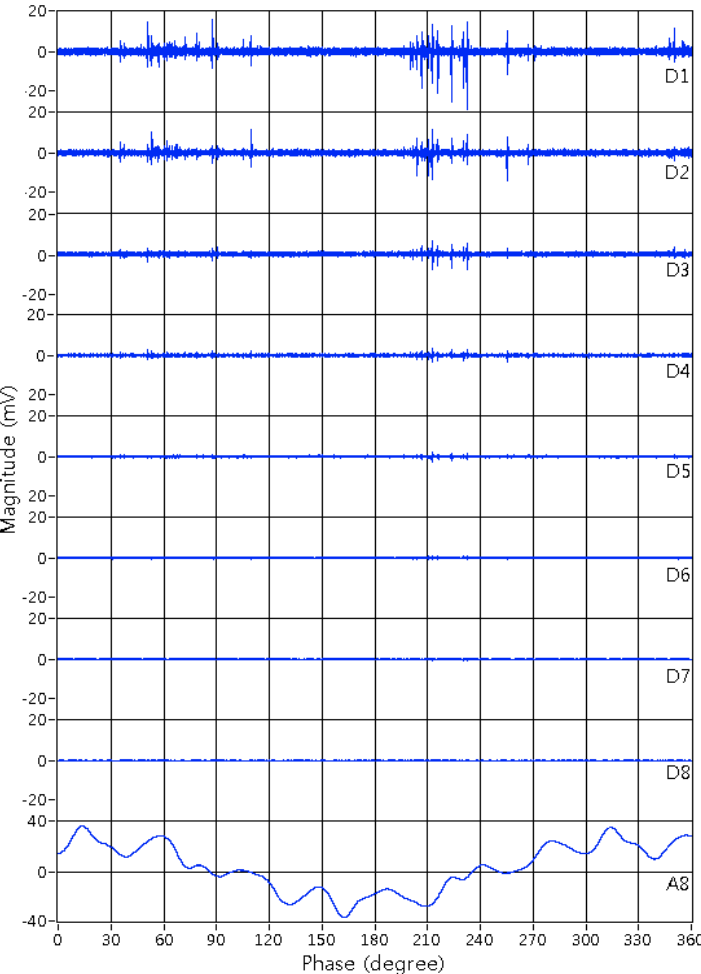
Figure 6. Decomposition of the phase-resolved partial discharge (PRPD) signal in the VIS into 8 levels.